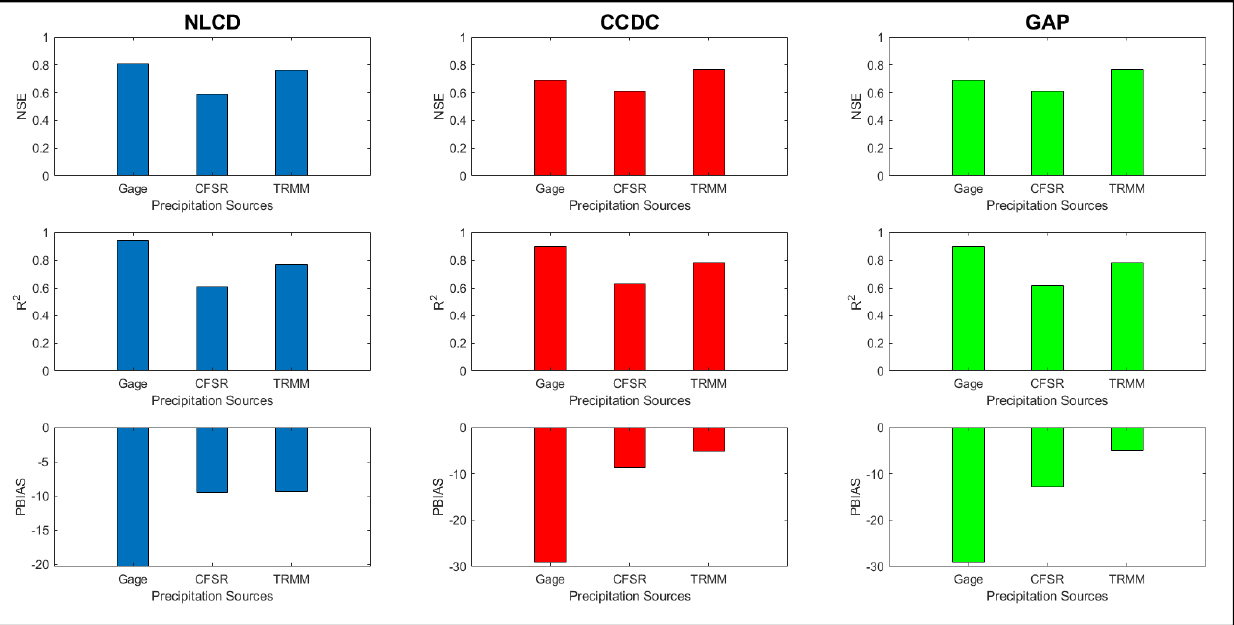
Figure 9. Model performance with various LULC and precipitation dataset combinations for the USGS DEM based on NSE, R 2 , and PBIAS criteria.